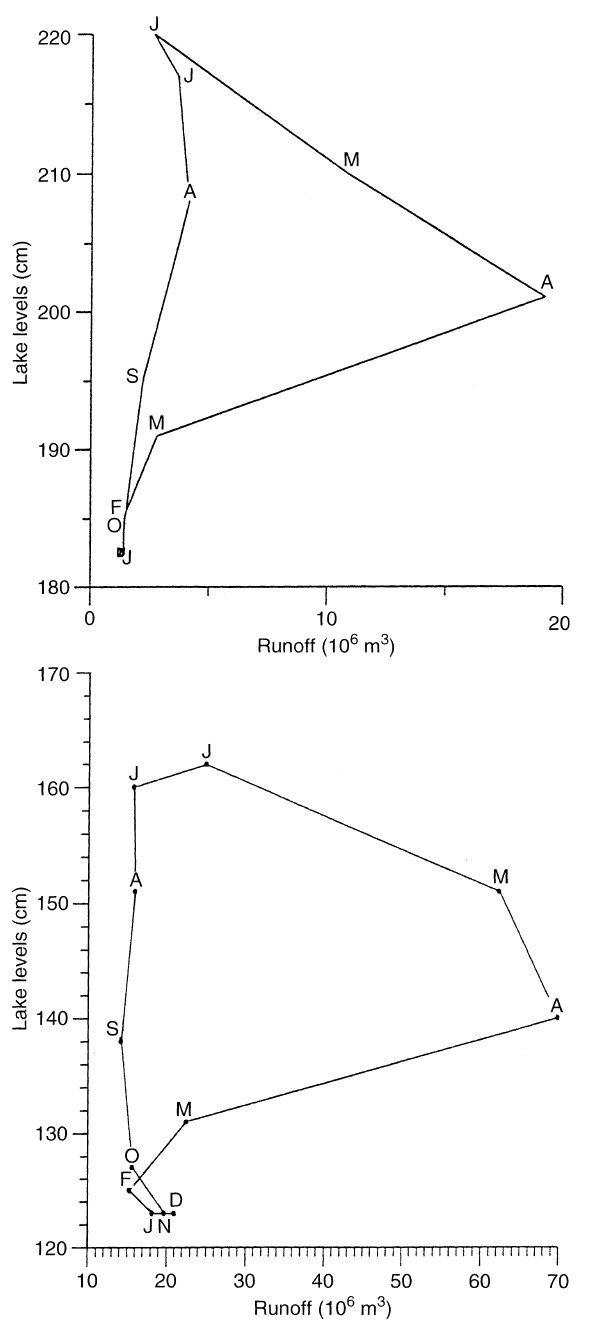
Fig. 10a, b. Lake level-local runo(cid:128) polygons a Su¨ frezor, b